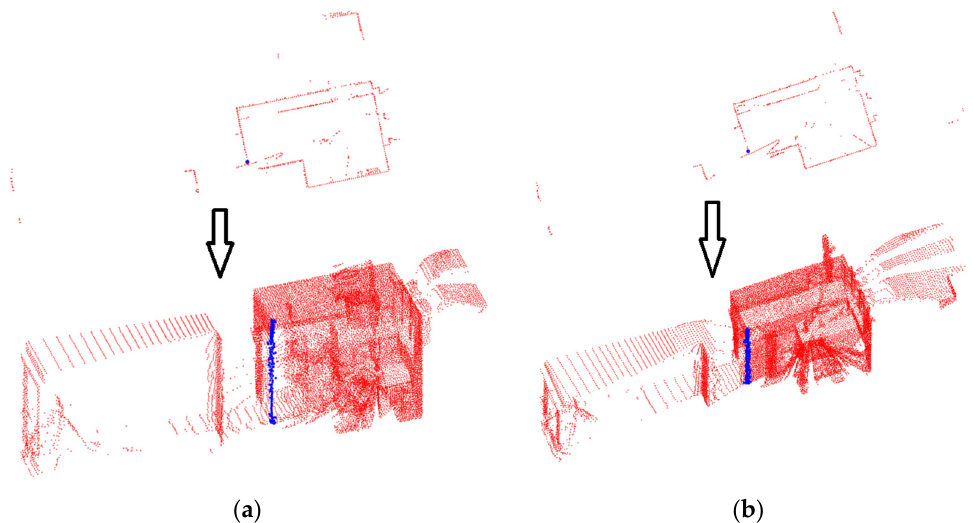
Figure 3. The illustration of the extraction of the points in the cylindrical neighborhood. The blue points are the extracted points by using the cylindrical neighborhood. (a) The simplified 2D point cloud (cid:2172) (cid:3013)(cid:3036)(cid:3041)(cid:3032)(cid:2879)(cid:3046)(cid:3046) and the source point cloud (cid:2172) (cid:3046) , (b) the simplified 2D point cloud (cid:2172) (cid:3013)(cid:3036)(cid:3041)(cid:3032)(cid:2879)(cid:3046)(cid:3047) and the target point cloud (cid:2172) (cid:3047) .